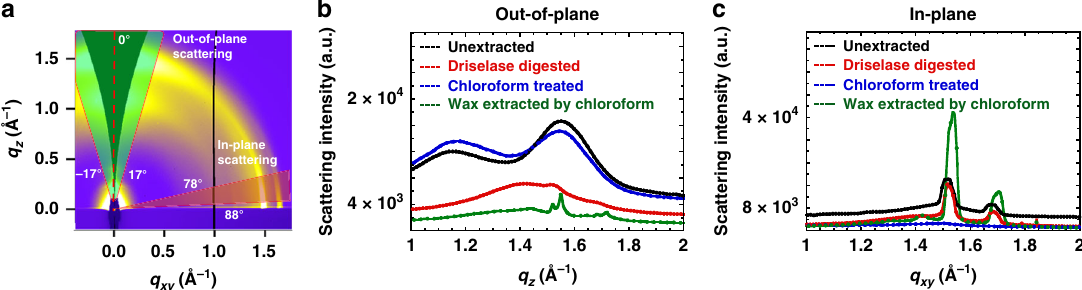
Fig. 2 GIWAXS of chemically treated onion epidermal cell wall decouples scattering from cellulose and epicuticular wax crystals. GIWAXS data from a Driselase-digested onion epidermal cell wall, b chloroform-treated onion epidermal cell wall, and c drop-cast wax that was extracted from the onion epidermal cell wall by